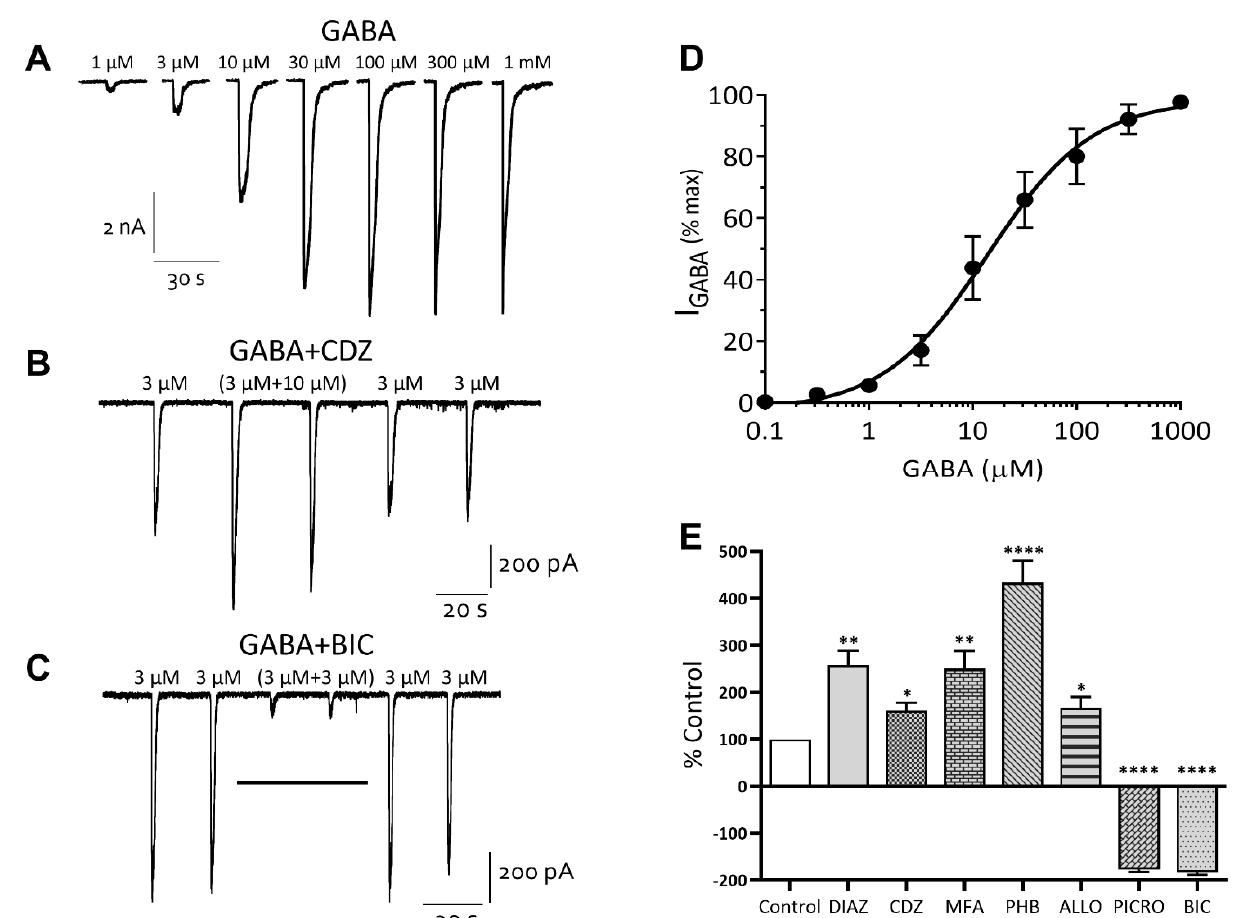
Figure 6. iCell neurons express GABA A receptor gated chloride channels. ( A ) GABA evokes concentration-dependent currents. ( B ) sub-maximal currents are potentiated by chlordiazepoxide (CDZ) and ( C ) inhibited by bicuculline (BIC). The holding potential of cells was − 60 mV. ( D ) A semi-log-linear plot of the GABA concentration-response relationship recorded from iCell neurons. The symbols represent the mean ± SEM of n = 11 cells. ( E ) a histogram summarizing the effects of diazepam (DIAZ, 10 µ M), chlordiazepoxide (CDZ, 10 µ M), mefenamic acid (MFA, 30 µ M), phenobarbital (PHB, 100 µ M), allopregnanolone (ALLO, 0.2 µ M), picrotoxin (PICRO, 10 µ M) and bicuculline (BIC, 10 µ M) on sub-maximal GABA-evoked whole-cell currents. Each bar represents the mean ± SEM of 4–6 cells. * p ≤ 0.05, ** p ≤ 0.01; **** p ≤ 0.0001.